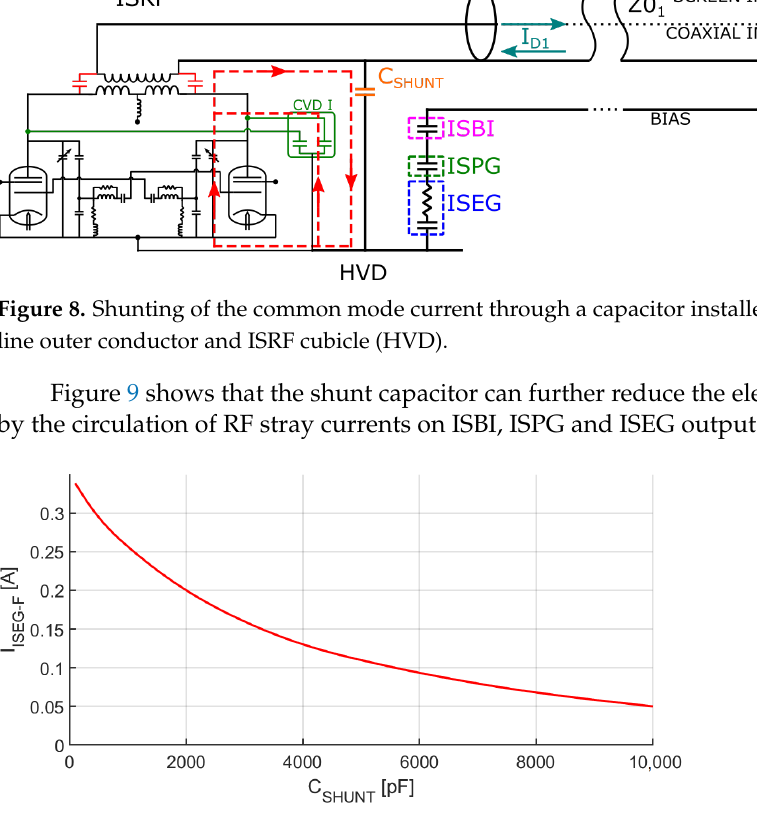
Figure 9. Reduction of RF stray current (RMS value) through ISEG output filter due to the installation of a shunt capacitor between RF coaxial outer conductor and ISRF